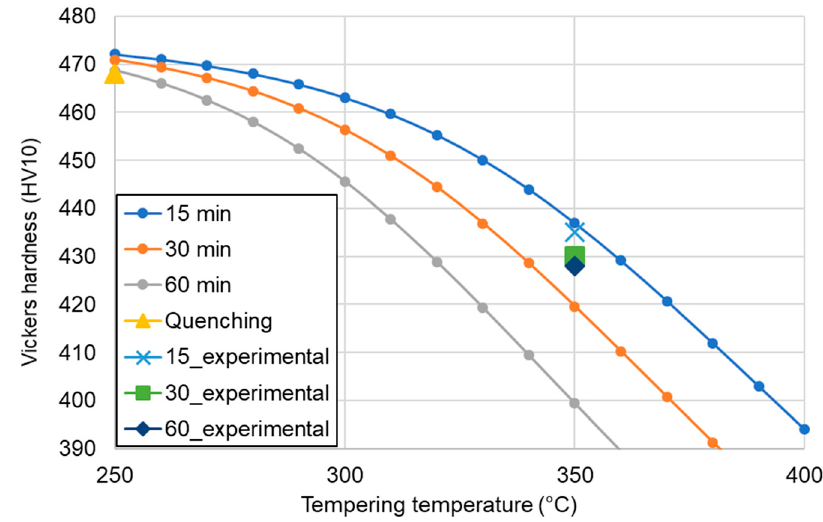
Figure 9. Comparison of the hardness results from the JMatPro simulations and the experiments.